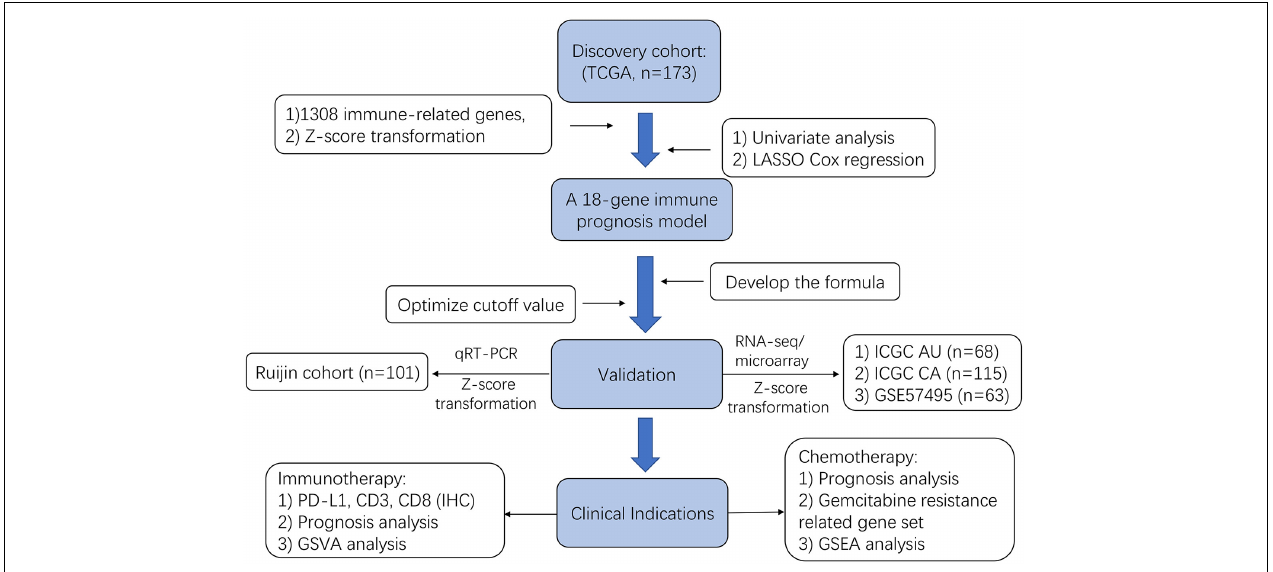
FIGURE 1 | Flowchart presenting the process of construction of immunity-related 18-gene signature, validation and clinical significance relevance in this study.